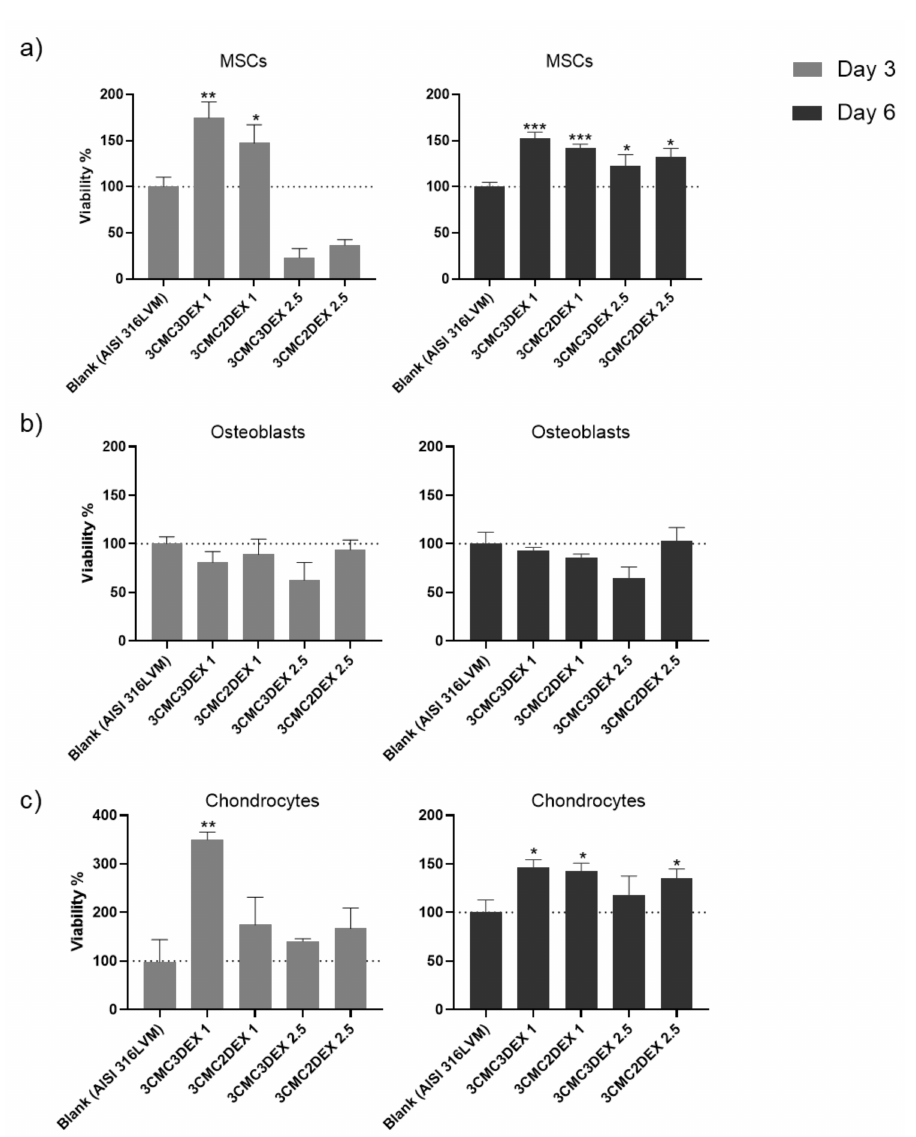
Figure 8. The cell viability testing results of ( a ) mesenchymal stem cells, ( b ) osteoblasts, and ( c ) chon- drocytes cultured on uncoated and CMC/DEX-coated AlSI 316LVM scaffolds after 3 and 6 days of incubation. Cell viability is expressed as % relative to control (uncoated AISI 316LVM). Values are shown as the mean ± standard deviation (three replicates). Statistical significance was defined as * p < 0.05, ** p < 0.005, and *** p < 0.0005 compared to the control sample (ANOVA